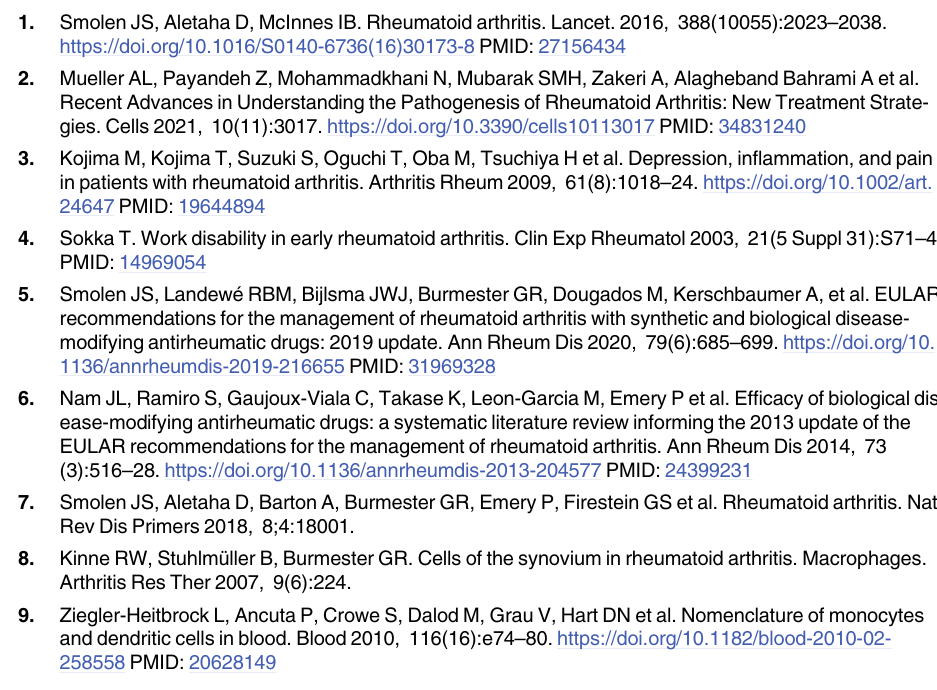
S1 Fig. Heat maps showing the transcript levels of the genes significantly modified in monocytes isolated from tocilizumab- (TOCI) and MTX-treated RA patients. Each row represents the (log2) expression profile of a different DEG centred around its median value, while columns are individual